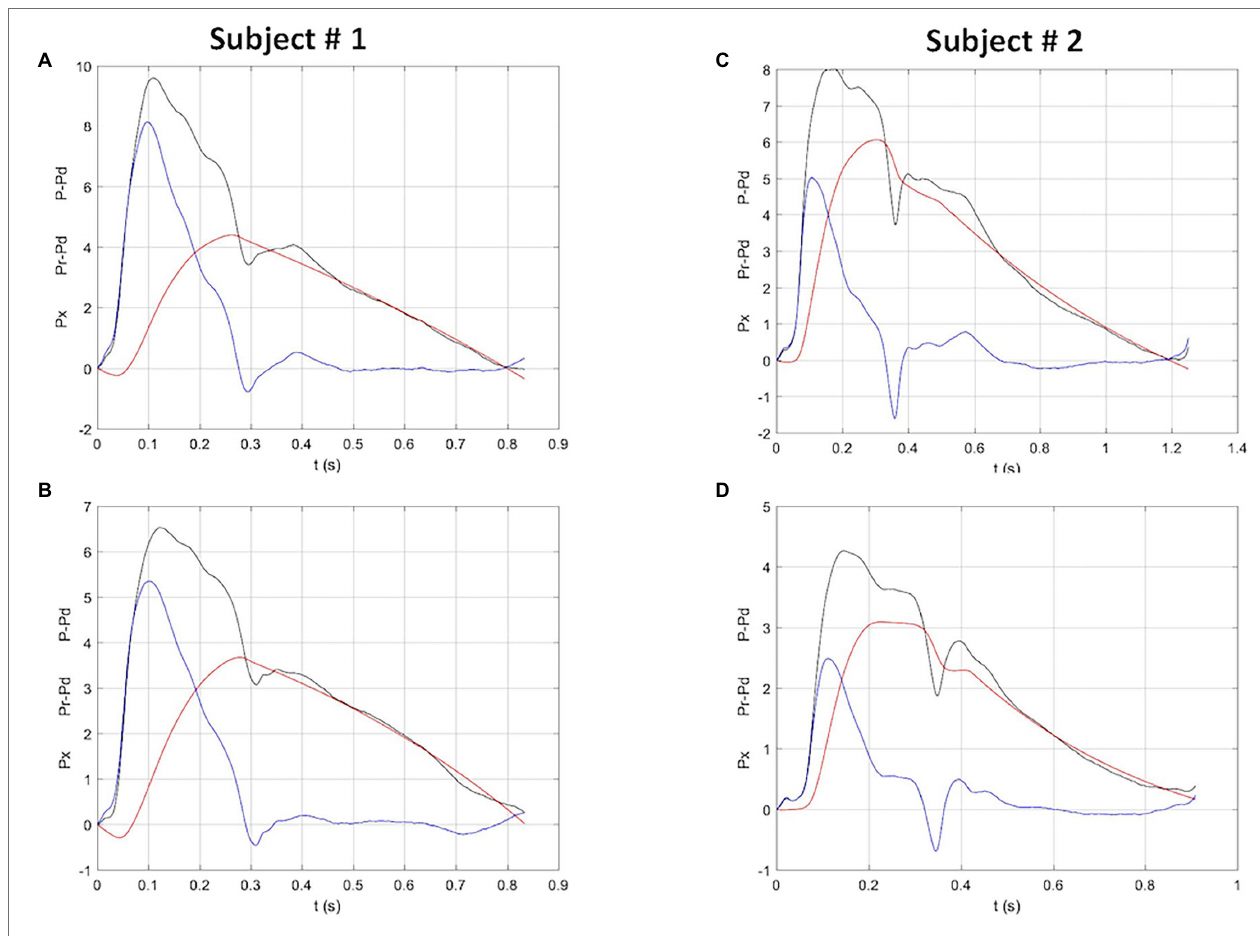
FIGURE 1 | Reservoir, excess and net pressure waveforms (red, blue and black, respectively), in two study subjects before ( top panels ) and after ( bottom panels ) bed rest. Both subjects show a reduction in net, reservoir and excess pressure. Subject # 2 also shows a clear reduction of the time to peak reservoir pressure. P-Pd, peak systolic pressure minus diastolic pressure; Pr-Pd, reservoir pressure minus diastolic pressure; Px, excess pressure. Units: X -axis, seconds; Y -axis,